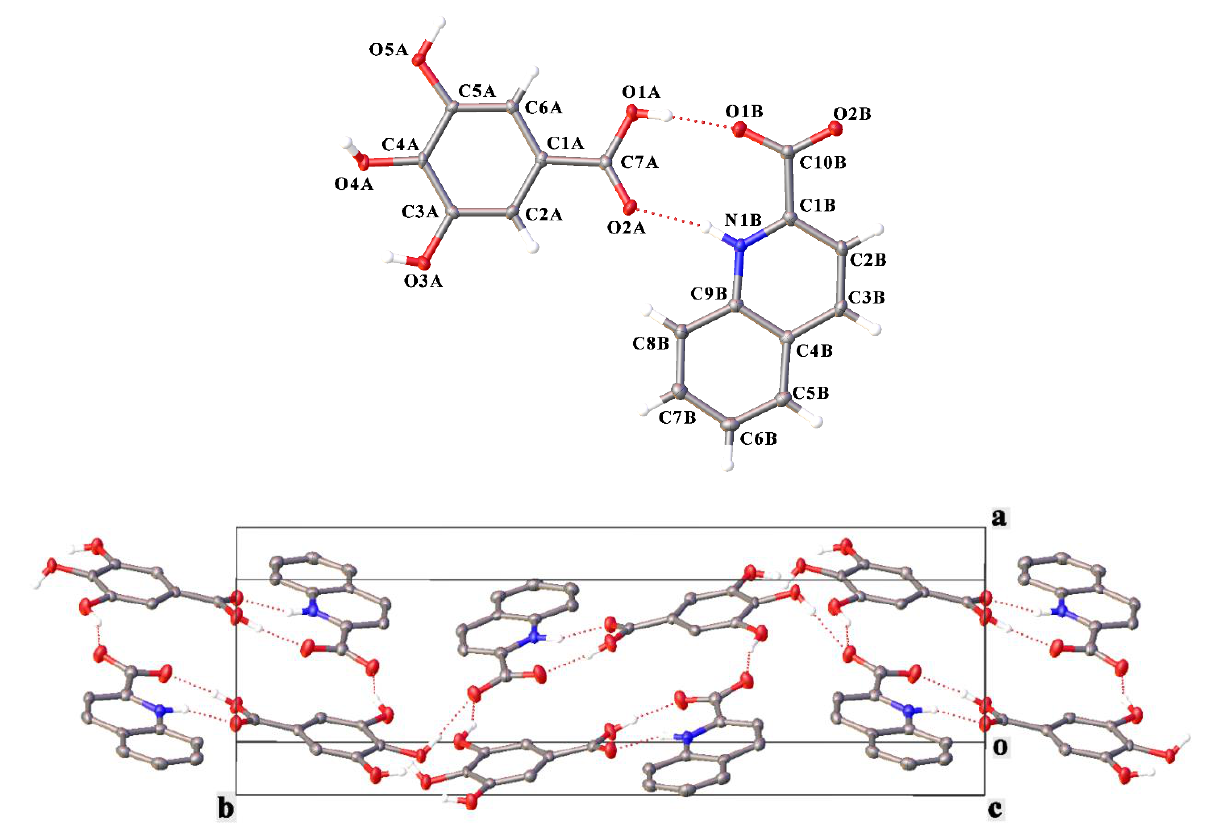
Figure 2. General view of 3 (top) and a fragment of its crystal packing (bottom), illustrating the formation of hydrogen-bonded double layers. formation of hydrogen-bonded double